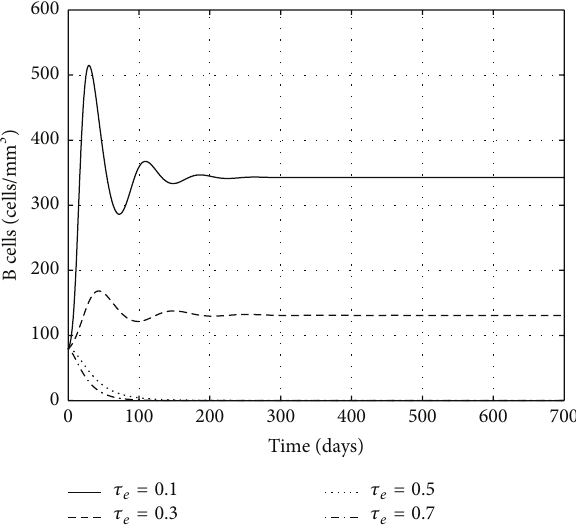
Figure 15: The concentration of B cells for model